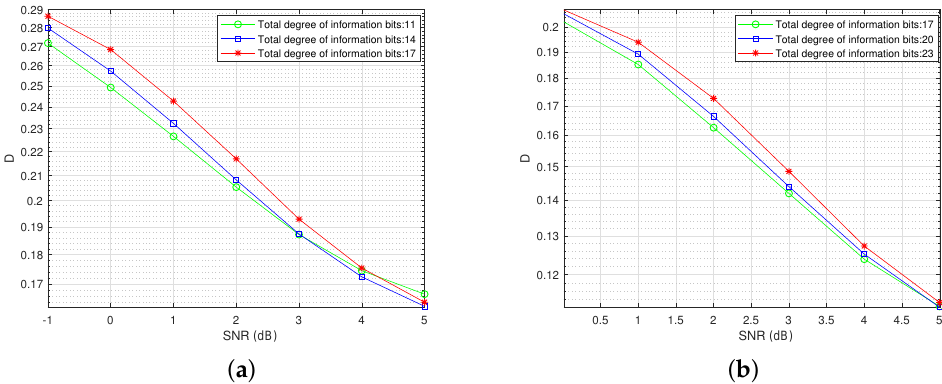
Figure 5. The influence of the total degree of the variable nodes corresponding to the information bit. ( a ) Code rate: 0.4 (RBP: 0.94 1.8) ( b ) Code rate: 0.57 (RBP: 0.85